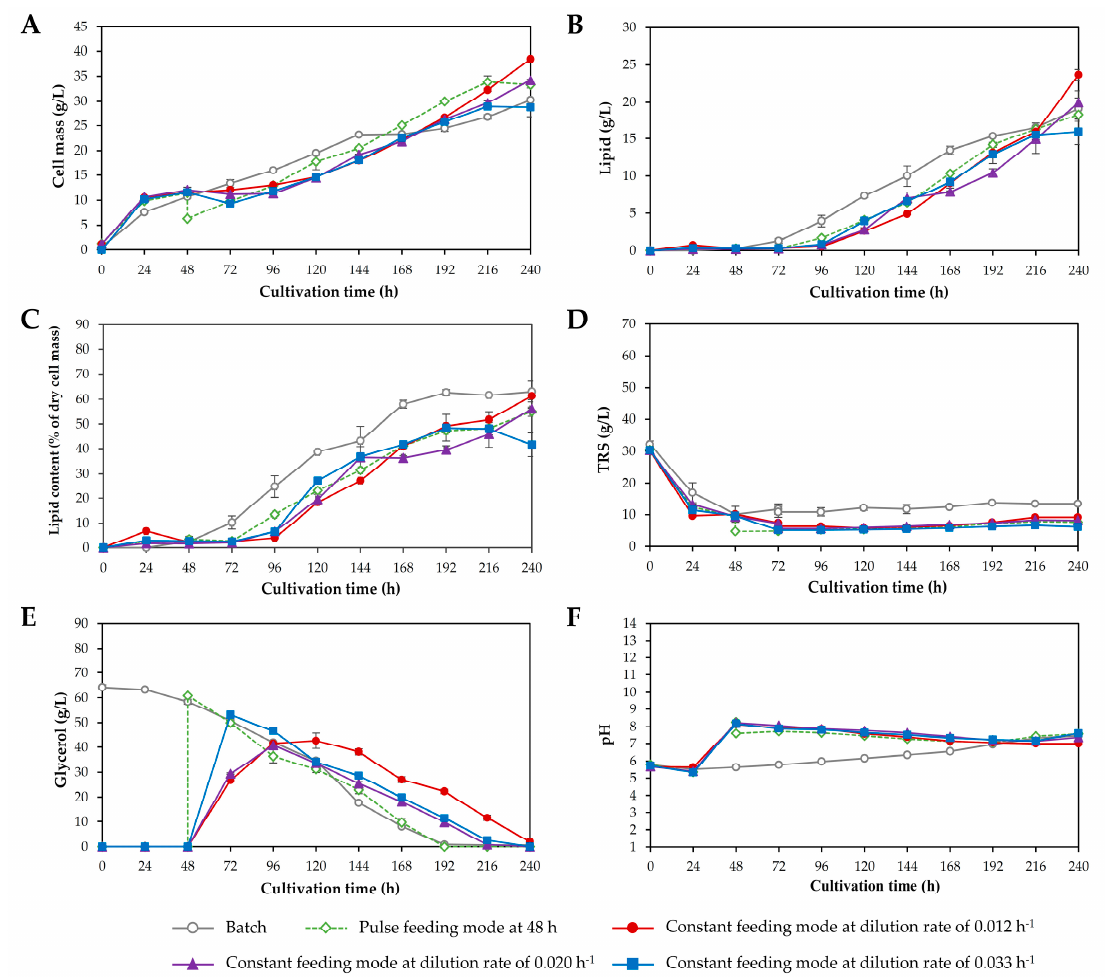
Figure 5. Lipid production by Rhodosporidiobolus fluvialis DMKU-SP314 in a 3 L stirred-tank fermenter using batch cultivation and two-stage fed-batch cultivation at a starting time point of 48 h with pulse feeding and constant feeding modes at different dilution rates of 0.012, 0.020, and 0.033 h − 1 . ( A ) Cell mass, ( B ) lipid, ( C ) lipid content, ( D ) total reducing sugars (TRS), ( E ) glycerol, and ( F ) pH.